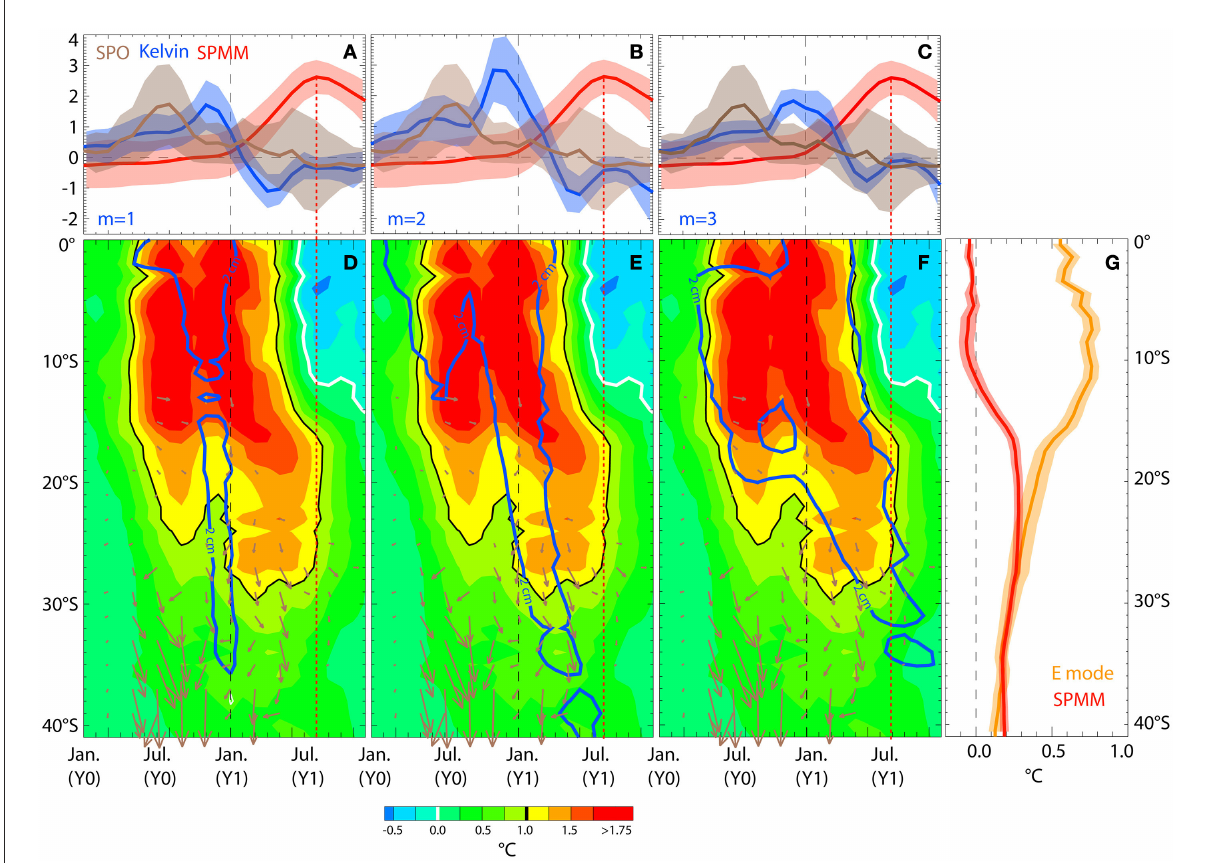
FIGURE6 Composite evolution during strong SPMM events (Number of events is 307) of the: (A–C) SPO index (brown line), the contribution of the m th baroclinic mode Kelvin wave to SSH anomalies at 95 ◦ W along the equator [blue line, (A) m 1, (B) m 2, and (C) m 3], and the SPMM index = = = (red line). (D–F) The SST (color), surface winds (brown arrows, for clarity arrows are only drawn to the south of 12 ◦ S and for negative meridional wind stress anomalies) and decomposed SSH (contours in blue line) anomalies along the west coast of South America (average within a 2 ◦ -width coastal fringe). Only the contour at 2cm is displayed for the decomposed SSH. (G) Displays the ensemble mean spatial pattern of the E mode (orange) and SPMM (red) modes (in ◦ C) along the west coast of South America (average within a 2 ◦ -width coastal fringe) and allows visualizing the region of influence of the two modes along the coast. The shading in corresponding color in all the panels indicates the dispersion amongst the ensemble (i.e., the standard deviation amongst the ensemble). The vertical dotted line in red indicates the culminating ± phase of the SPMM